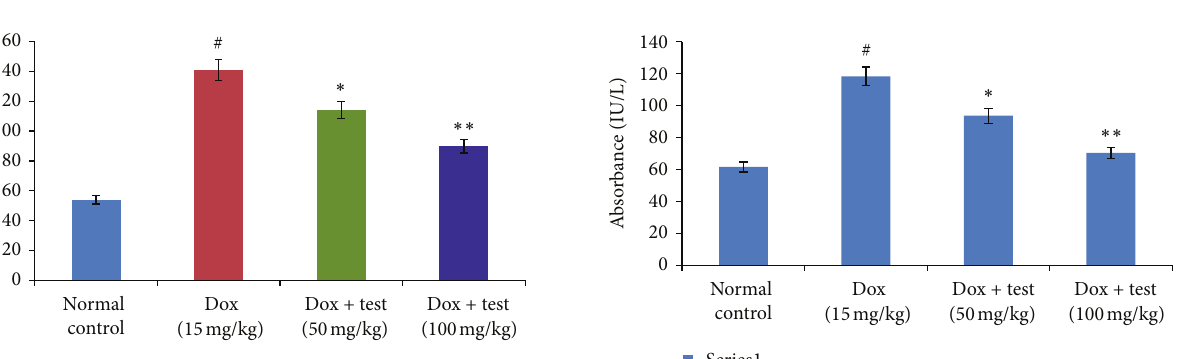
Figure3:EffectoftestcompoundonplasmaTGlevelsinratstreated with doxorubicin. # 𝑃 < 0.001 versus normal control; ∗ 𝑃 < 0.05 ; ∗∗ 𝑃 < 0.01 versus dox.